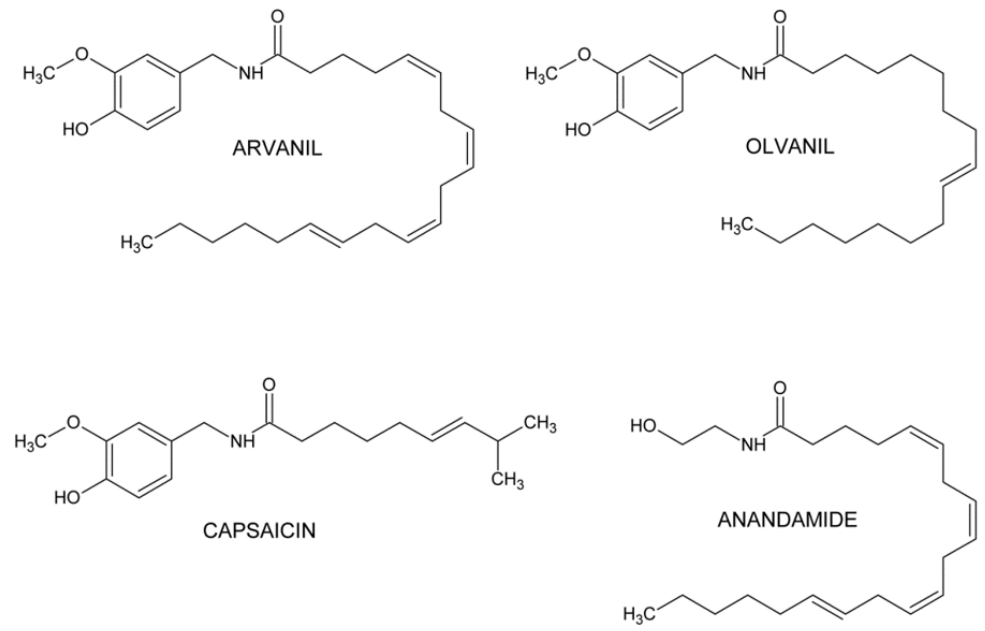
Figure 1. Chemical structure of arvanil and olvanil.